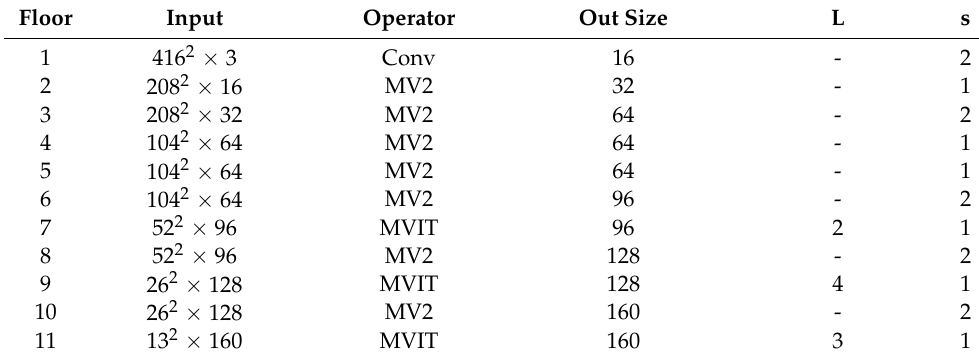
Table 1. The structural information of